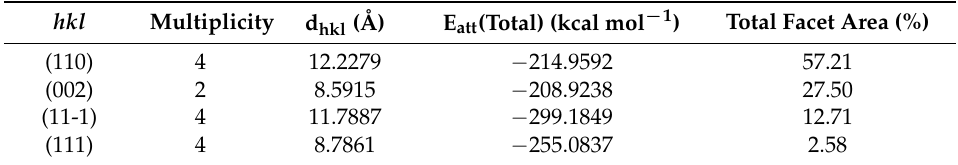
Table 5. Morphology predictions for 1 by means of GM calculations. Percentage of total facet